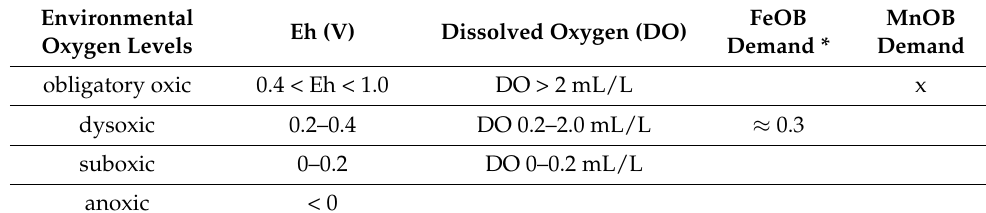
Table 2. Environmental oxygen levels.